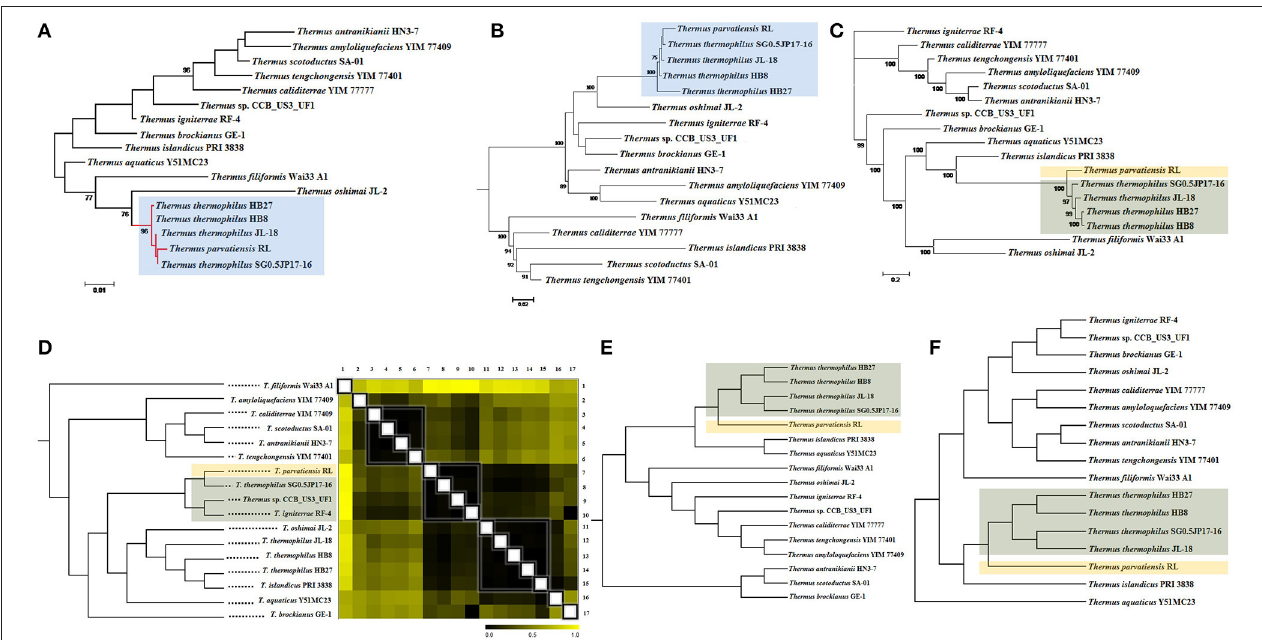
FIGURE 2 | Inference of evolutionary relationships among Thermus spp. based on phylogenetic and phylogenomic methods. Phylogenetic analysis based on (A) 16S rRNA gene sequences; (B) 31 single copy genes; and (C) 400 conserved bacterial marker genes, of the species under study using maximum likelihood method. Bars represent the number of substitutions per nucleotide position. Percentage bootstrap values ( ≥ 70%) are shown next to the nodes. Phylogenomic dendrograms showing hierarchical clustering of species under study constructed using (D) whole genome distance matrix based on ANI scores; (E) tetranucleotide frequencies; and (F) pan genes presence-absence matrix. Gradation of colors from black to yellow in (D) depicts increasing genome distance on the basis two-way ANI matrix. Black denotes minimum distance and yellow denotes maximum distance. Organisms have been grouped together into clades on the basis of minimum distance (black). Blue shade (in A,B ) depicts clustering of T. parvatiensis within T. thermophilus group. Light brown shade (in C–F) depicts the position of T. parvatiensis separately from other closely clustered Thermus members (shaded gray in C–F)